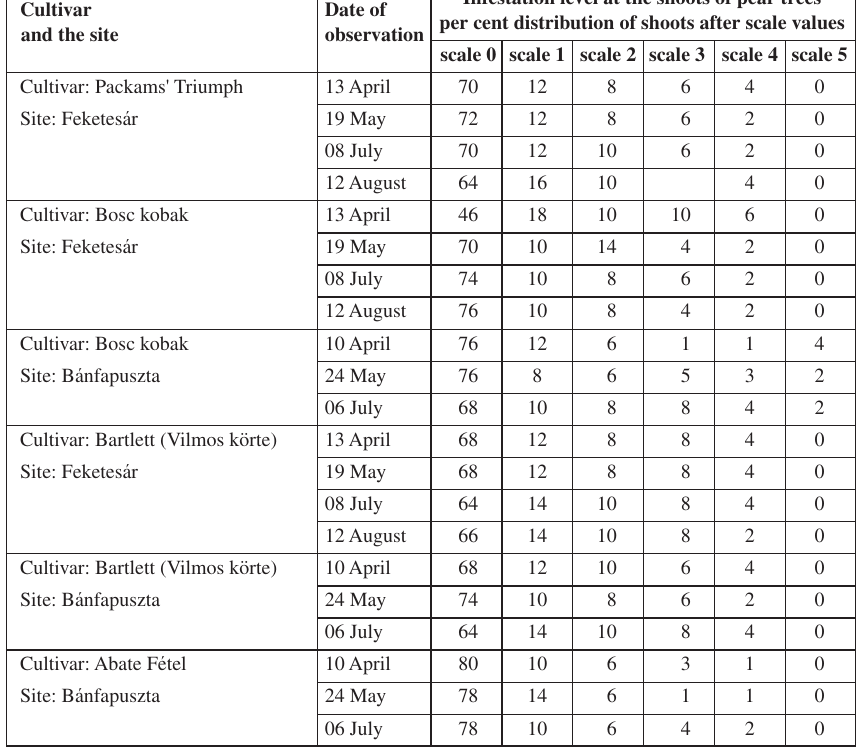
Table 3. Pear psylla infestation to some widely grown European pear cultivars under the pressure of standard plant protection practice (Gyümölcsöskert Kft. 2009) Infestation level at the shoots of pear trees Cultivar Date of per cent distribution of shoots after scale and the site observation